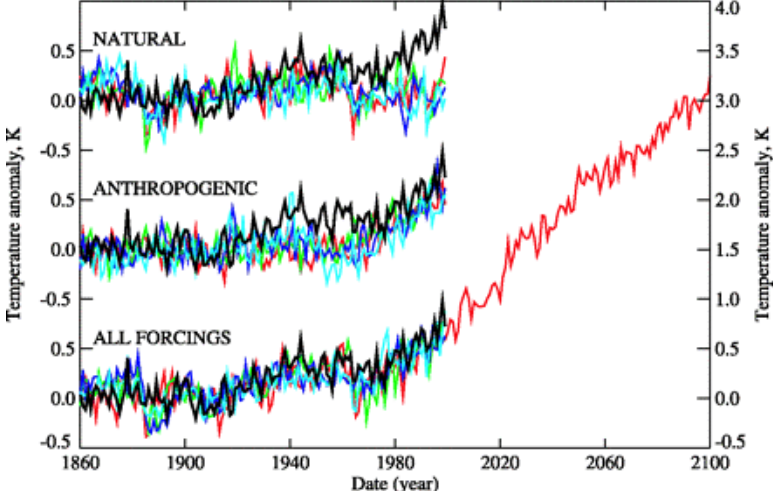
FIGURE 25. Annual-mean global surface temperature anomalies (relative to 1881–1920). Black curves are the observations, colored are individual simulations (see